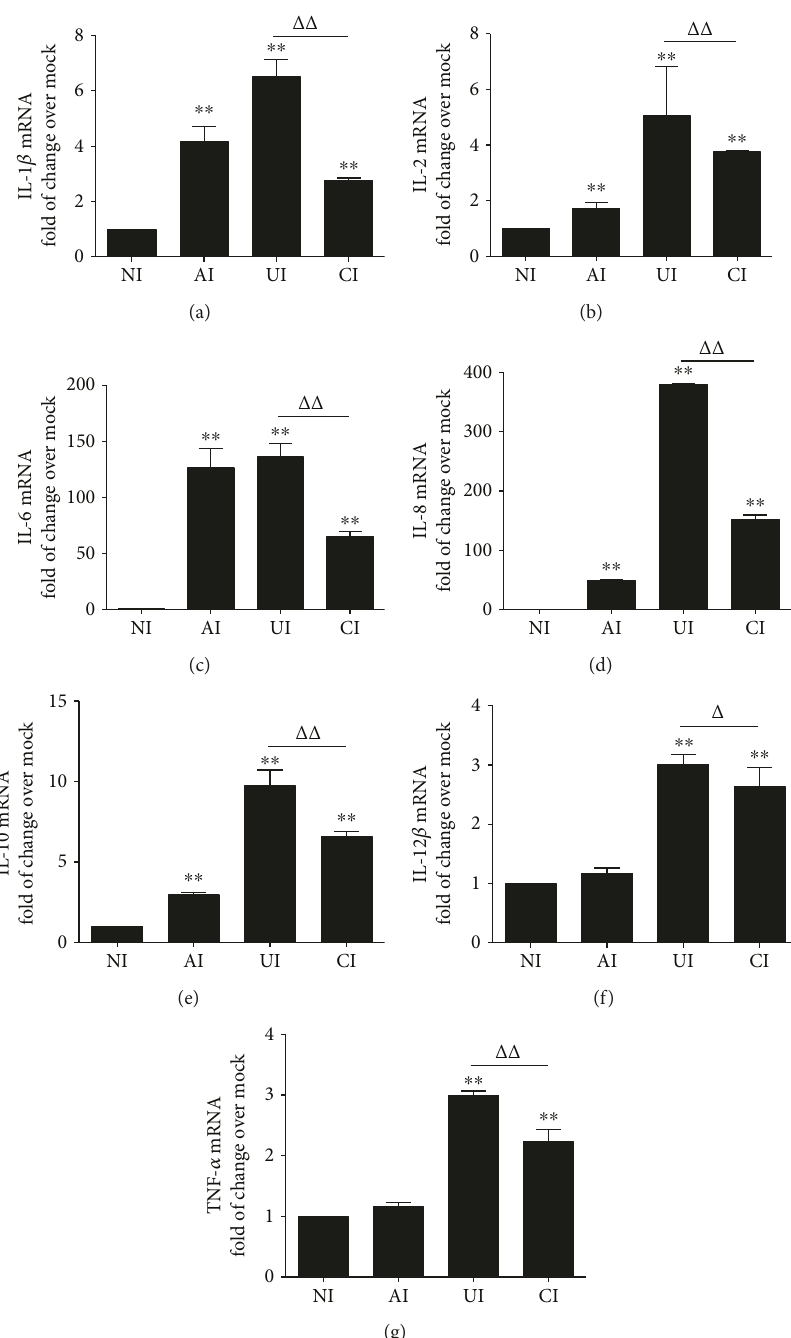
Figure 3: Mtb H37Rv-infected A549 cells reduced the expression of cytokines of U937 cells in response to mycobacterial infection. The coculture model of A549/U937 cells was infected with H37Rv mycobacteria from the upper chamber (A549 cells, AI), lower chamber (U937 cells, UI), or both chambers (A549 and U937 cells, CI) at a MOI of 3 for 18h before the U937 cells were harvested for analysis by a RT-PCR assay. (a – g) Inductions of indicated transcripts of U937 cells infected with H37Rv in di ff erent conditions. (a) Fold of changes of IL-1 β transcripts over the noninfected cells; (b) fold of changes of IL-2 transcripts over the noninfected cells; (c) fold of changes of IL- 6 transcripts over the noninfected cells; (d) fold of changes of IL-8 transcripts over the noninfected cells; (e) fold of changes of IL-10 transcripts over the noninfected cells; (f) fold of changes of IL-12 β transcripts over the noninfected cells; (g) fold of changes of TNF- α transcripts over the noninfected cells. Error bars represent the standard deviation (SD) from three independent experiments. Compared to noninfection (NI) control, ∗∗ p < 0 01 ; compared to infection of U937 cell alone, ΔΔ p < 0 01 . NI: noninfected control; AI: infection was performed on A549 cell alone; UI: infection was performed on U937 alone; CI: infection was performed on both A549 cells and U937